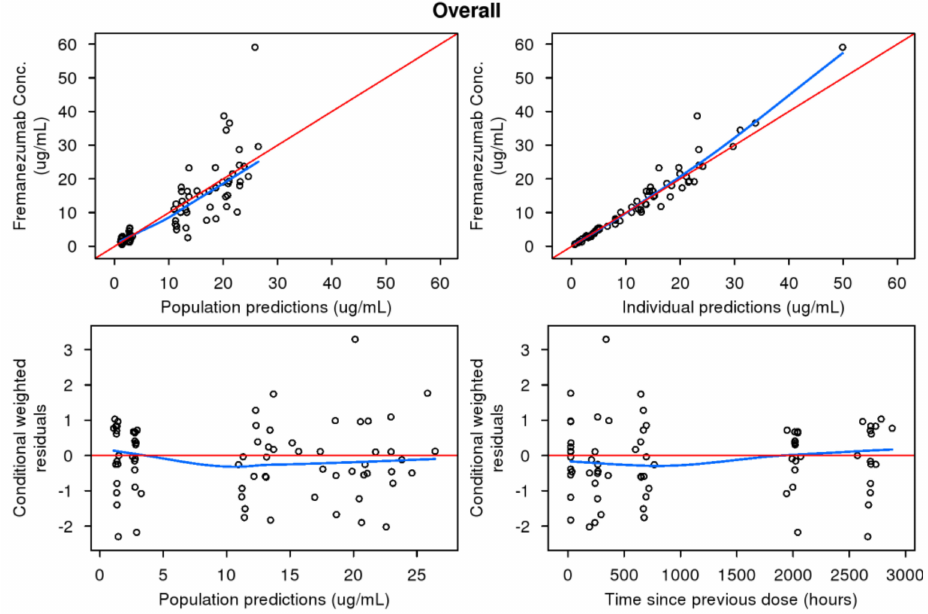
Figure 2. Goodness-of-fit diagnostic plots for the fremanezumab pediatric population pharmacoki- netic model. Conc: